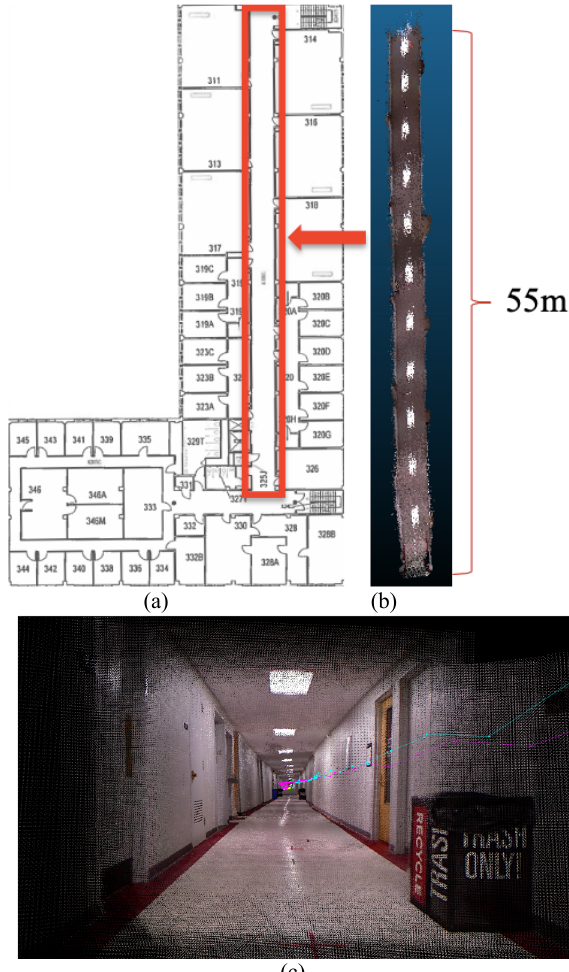
Figure 4. Experiment area (a) and the 3D model rendered by RTAB-map (b and c).